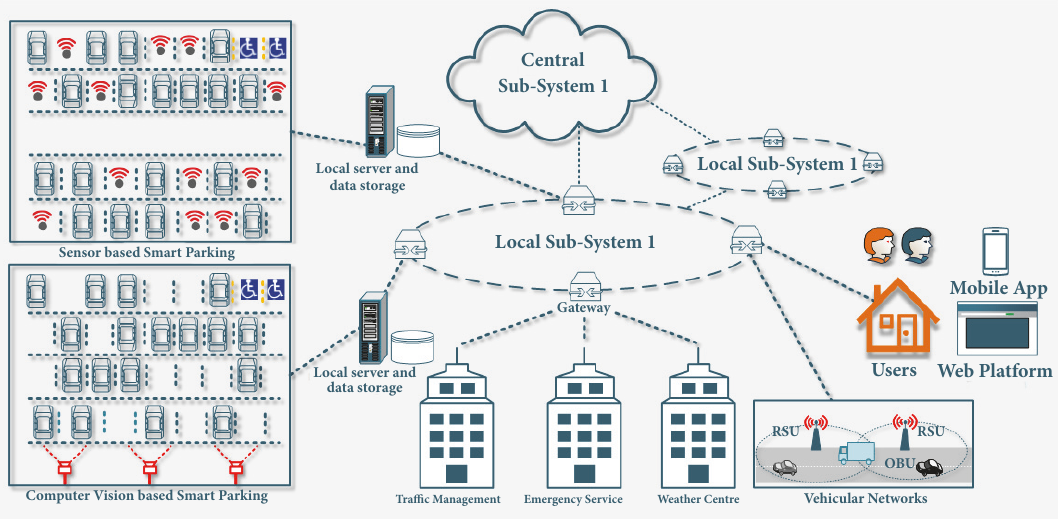
Figure 2: Distributed ITS